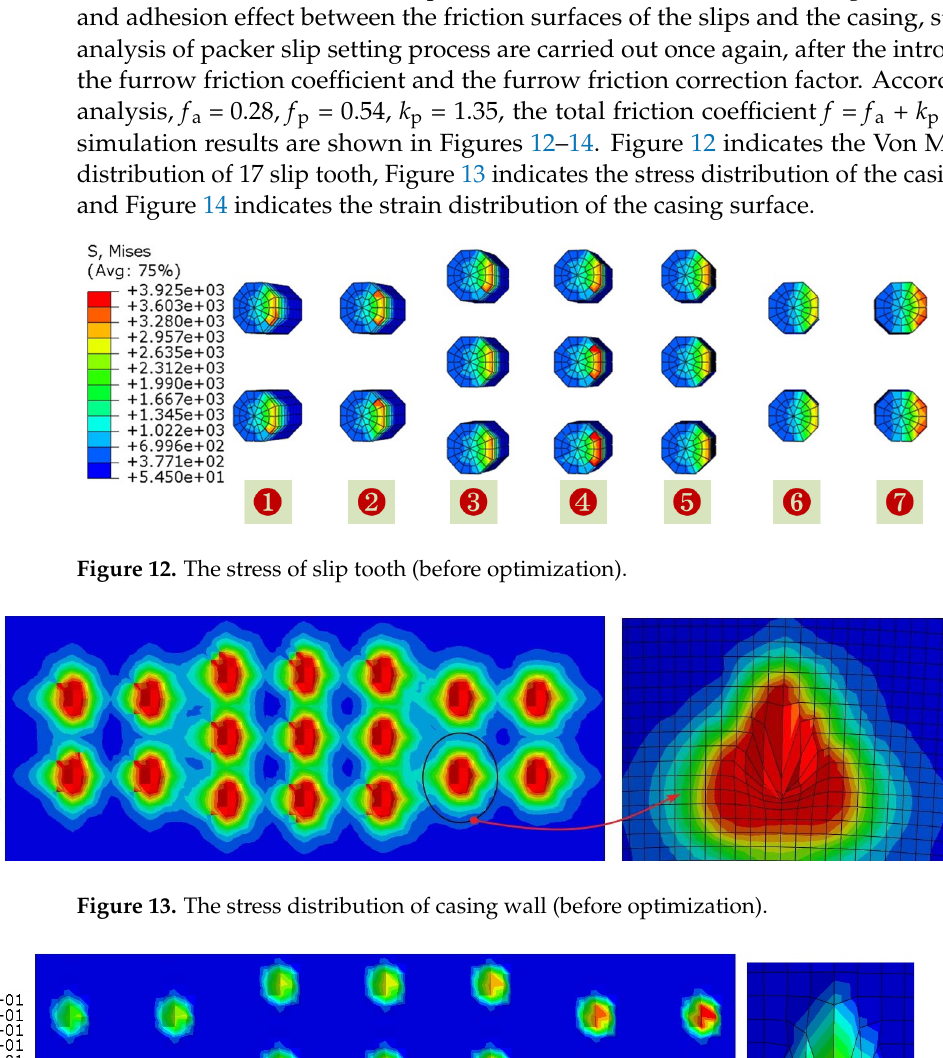
Figure 11. Ridge height and depth of single teeth.